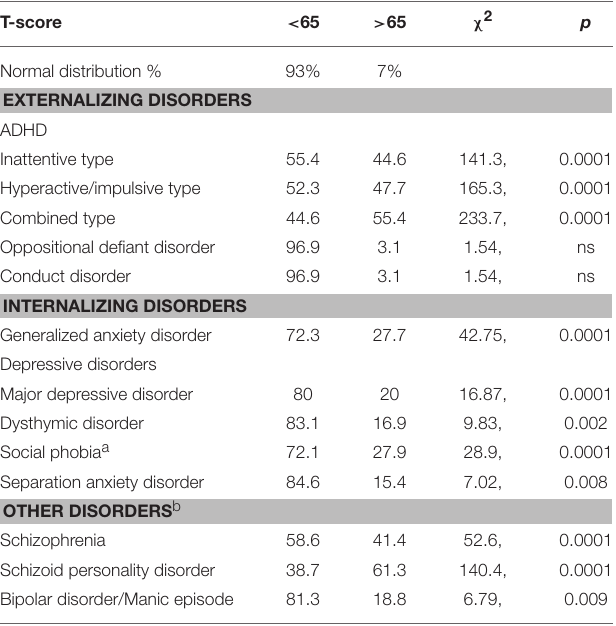
TABLE 5 | Means (and Standard Deviations) of T-scores on EDI factors by age-group.